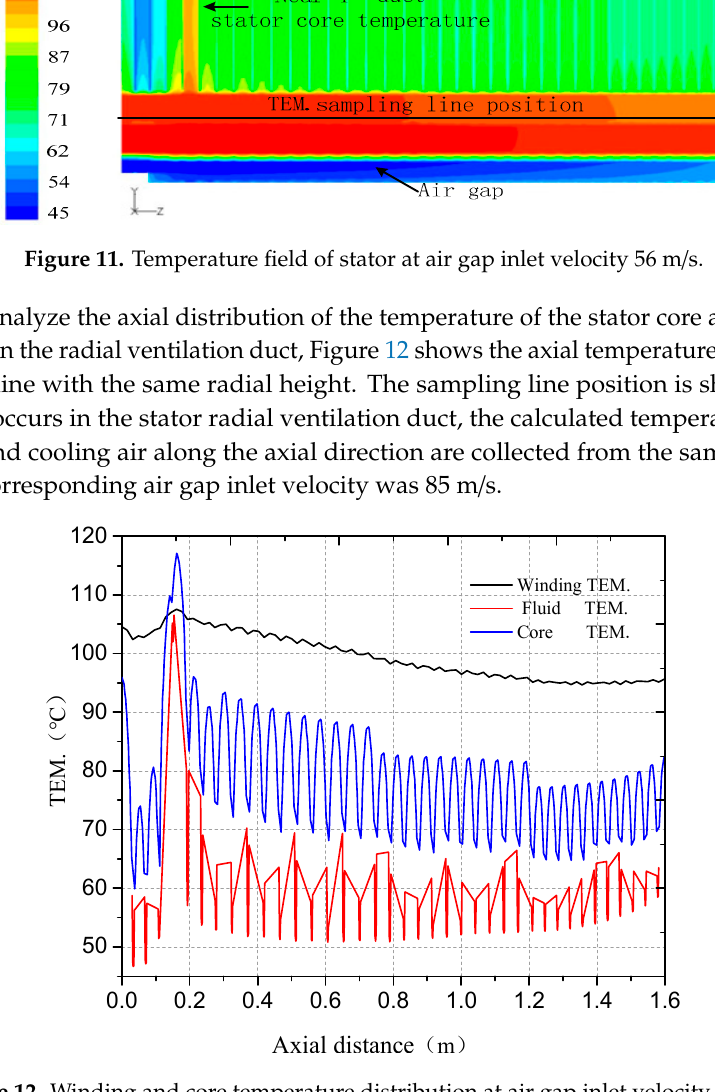
Figure 11. Temperature field of stator at air gap inlet velocity 56 m/s.